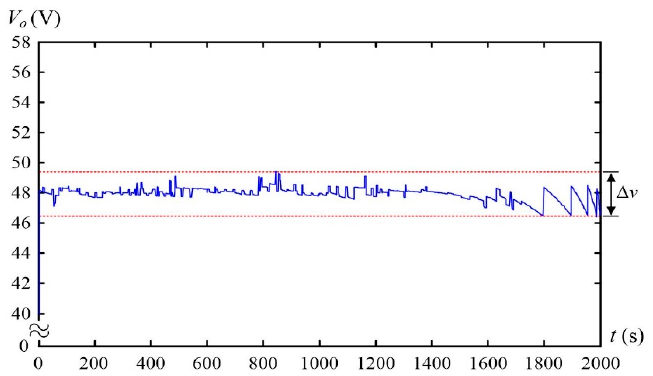
Figure 11. Output voltage of battery power bank.